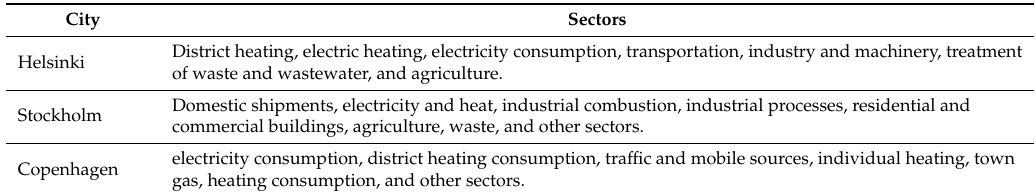
Table 2. Various sectors reported by case cities